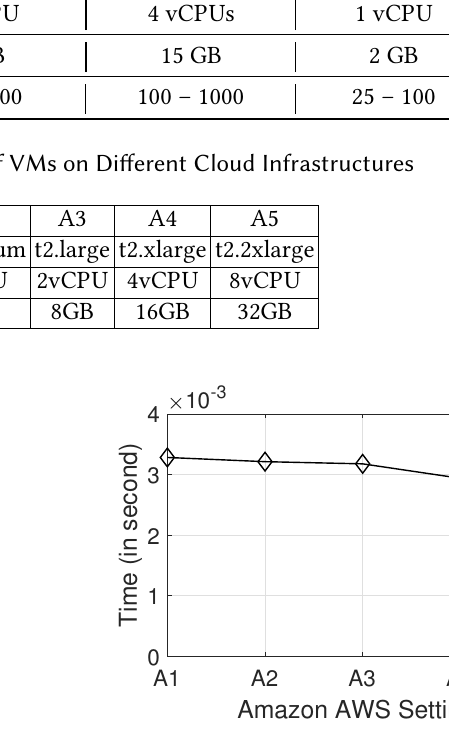
Figure 11. The time spent on updating the model Figure 12. The update time for different configurations of VMs